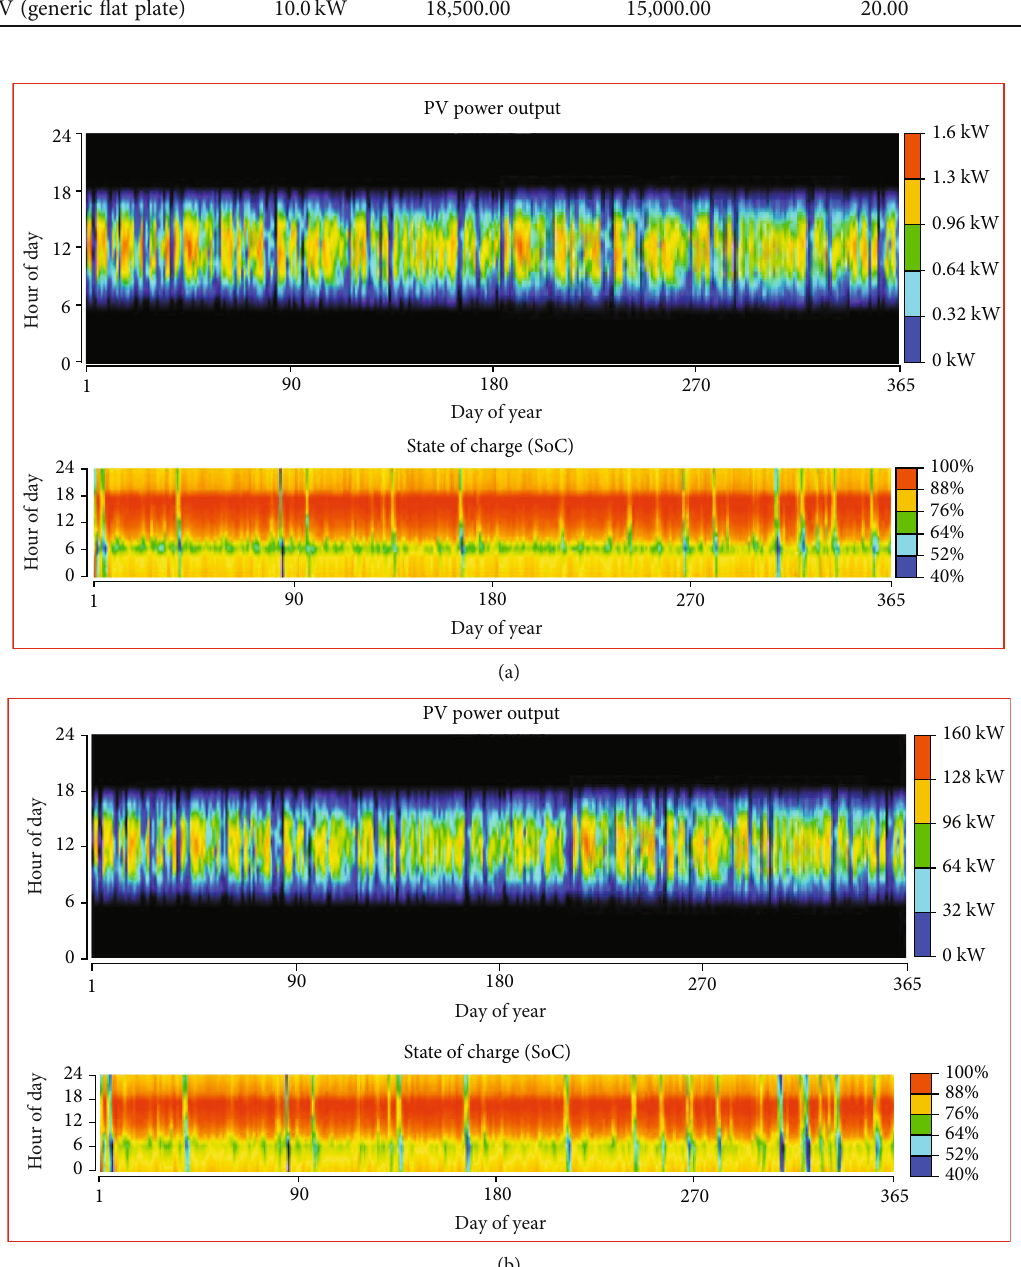
Figure 7: PV power output and SOC of the simulated solar photovoltaic systems: (a) the standalone photovoltaic for a single residential house and (b) the o ff -grid solar photovoltaic microgrid system for the rural community.